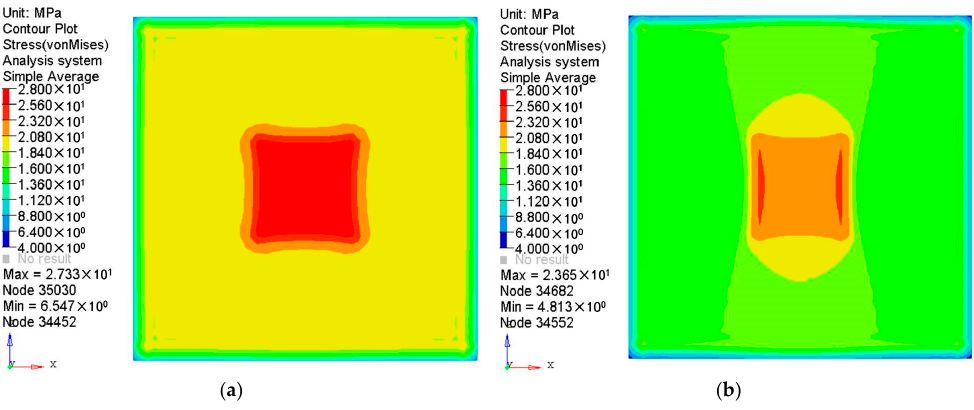
Figure 6. Thermal stress distributions of ( a ) isotropic and ( b ) orthotropic plates under the temperature difference of 30 K.